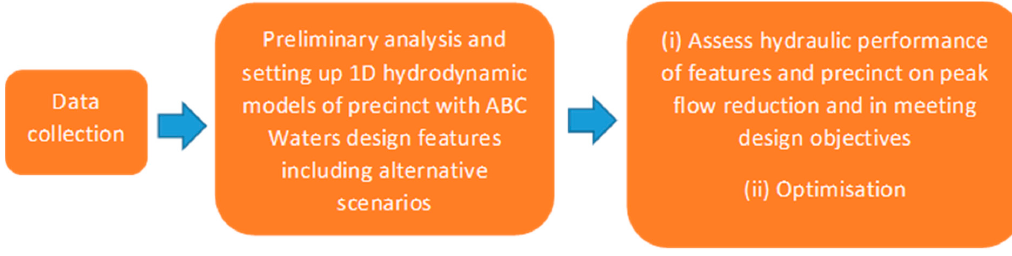
Figure 7. General workflow for the research methodology.